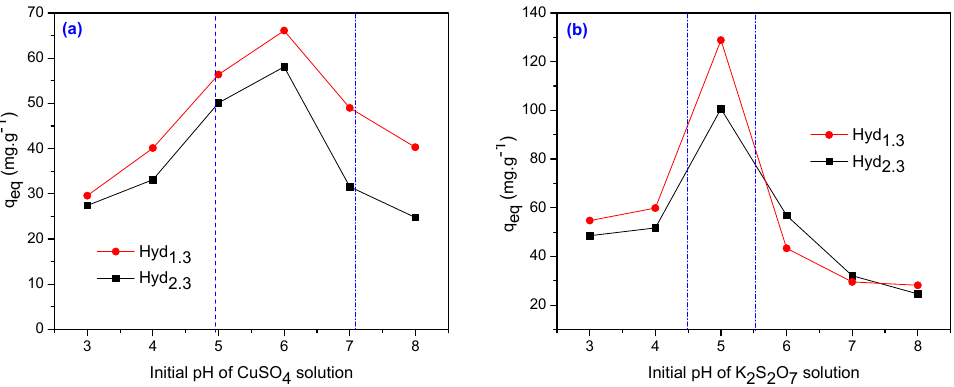
Figure 14. Effect of pH on ( a ) Cu 2+ and ( b ) Cr 6+ adsorption in Hyd 1.3 and Hyd 2.3 hydrogels (initial concentration: Cu 2+ and Cr 6+ 500 mg·L − 1 , dose: 0.5 g; volume 100 mL).